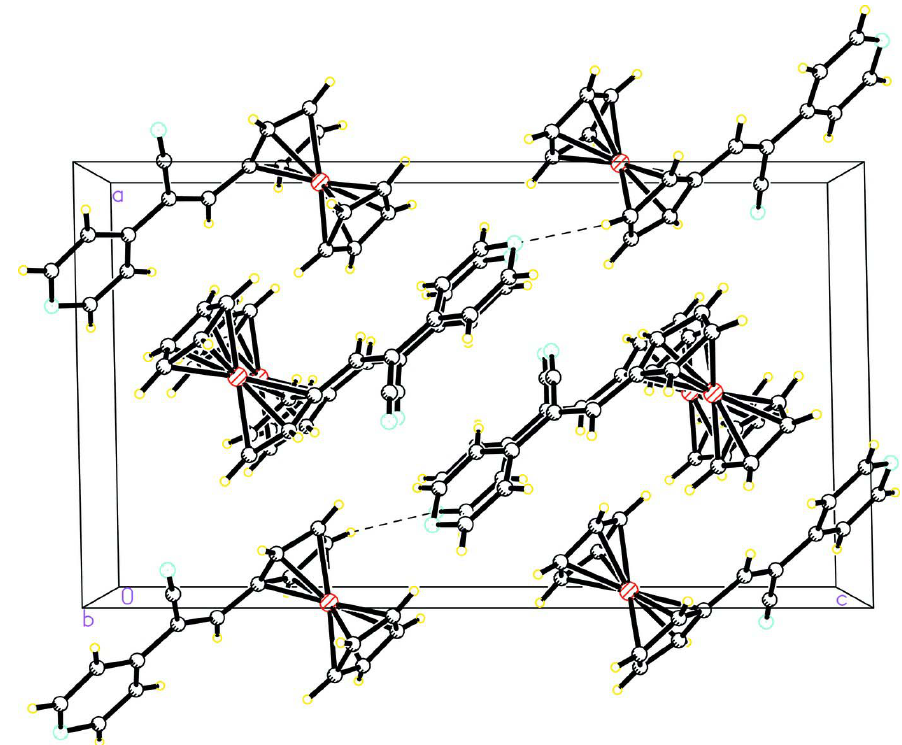
Figure 2 Packing of the title compound, viewed along the b axis. Dashed lines indicate C—H···N hydrogen-bond